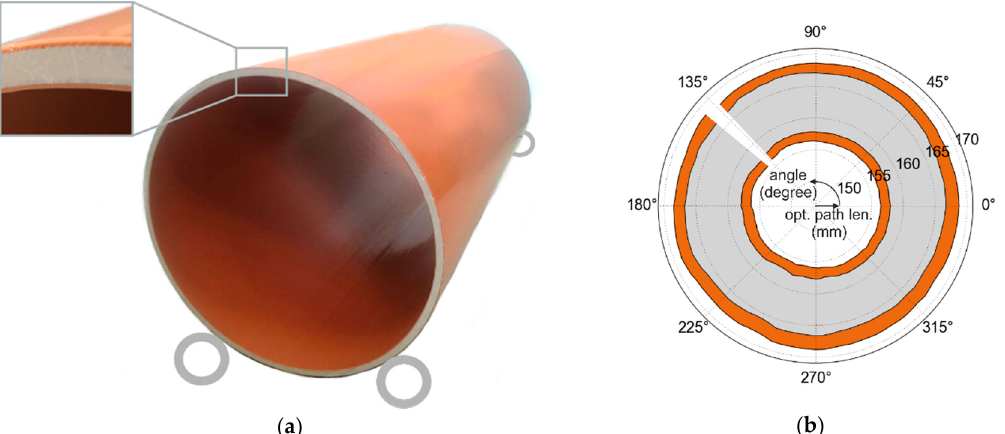
Figure 7. ( a ) Photograph of the SUT consisting of three layers including a schematic of the two pairs of wheels. ( b ) A mechanical measurement enables the conversion of the previous results to the optical path length (opt. path len.) to the ellipse center. The outer surface corresponds to the first reflection in Figure 8a.